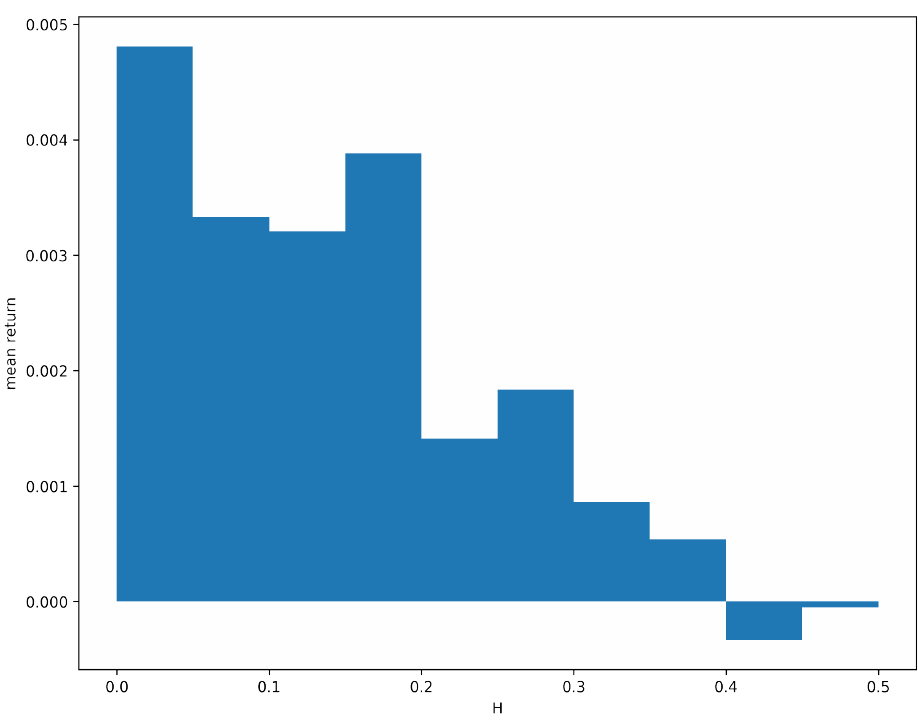
Figure 1. Comparison between the value of H and the mean return of the portfolios for the pe- riod 2000–2007.